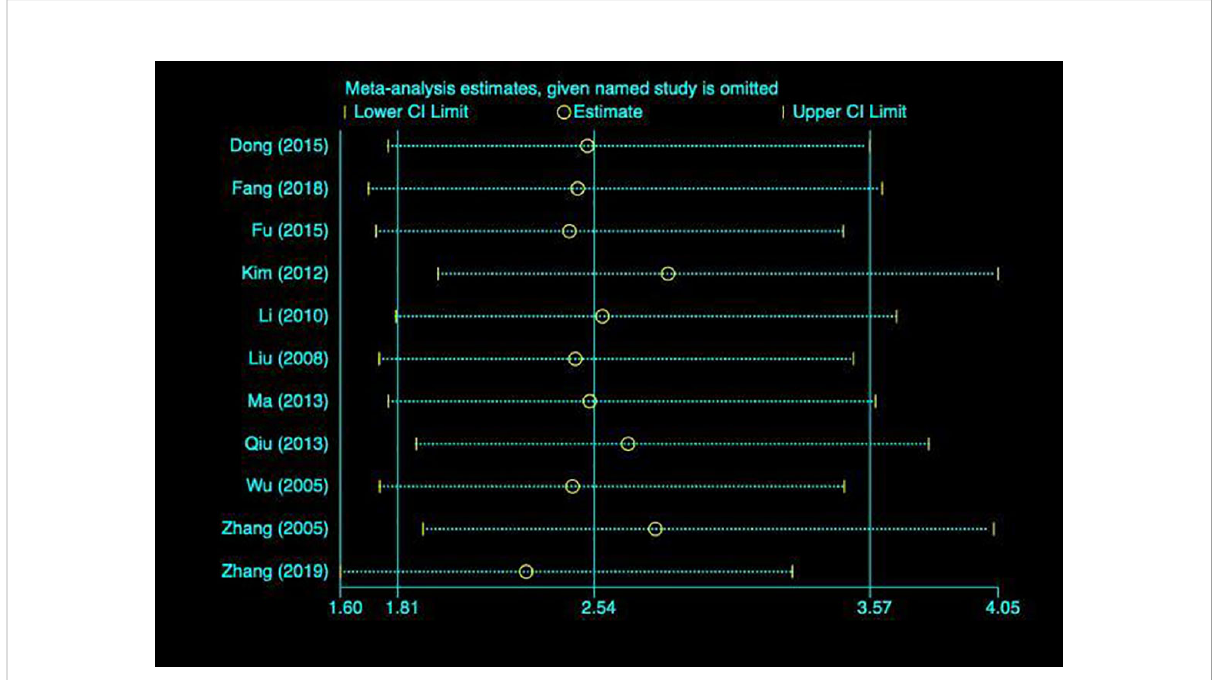
FIGURE 11 Sensitivity analysis. Each line represents the change in the result after removing the study, and the circle represents the combined effect size after removing the study.